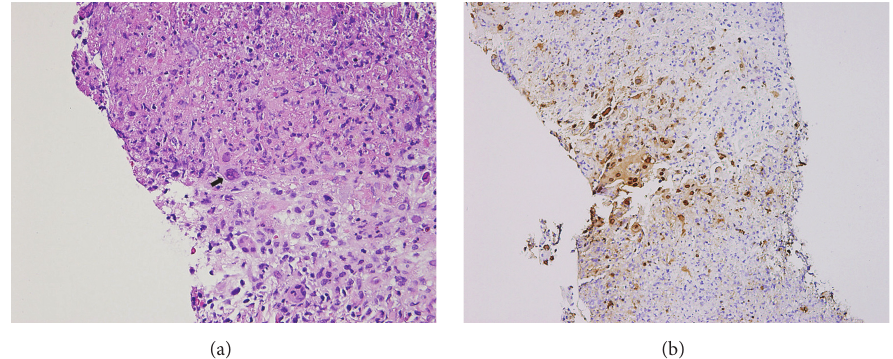
Figure 3: Immunohistochemical analysis of the liver biopsy: (a) high power view showing hepatocellular necrosis. Within the necrotic debris, viral eosinophilic, ground-glass nuclear inclusions can be seen as well as multinucleated cells with nuclear molding (see arrow) and (b) immunostaining for HSV-2 highlights the infected